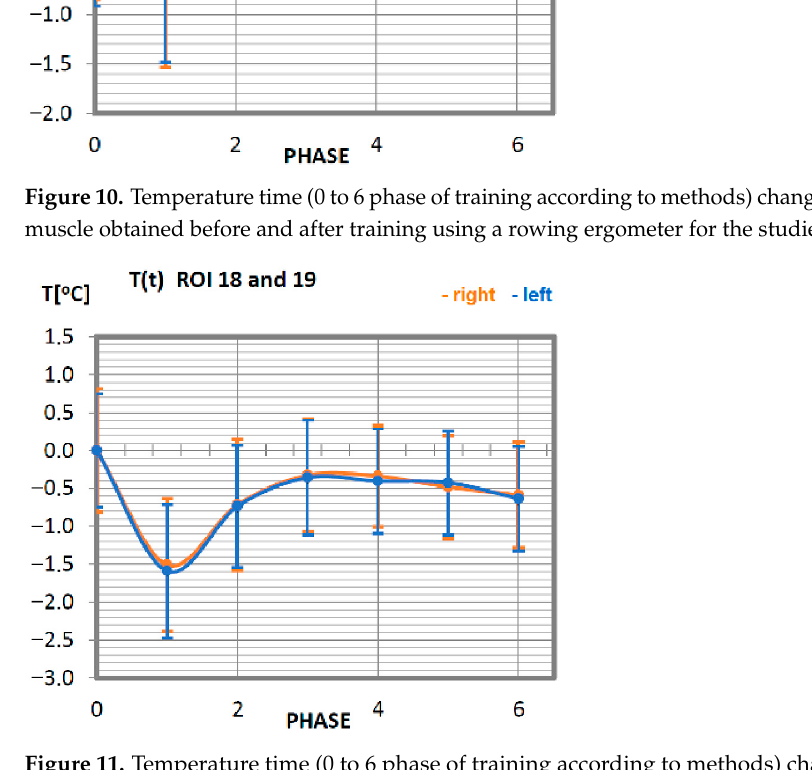
Figure 11. Temperature time (0 to 6 phase of training according to methods) changes of the deltoid muscle obtained before and after training using a rowing ergometer for the studied group of athletes.